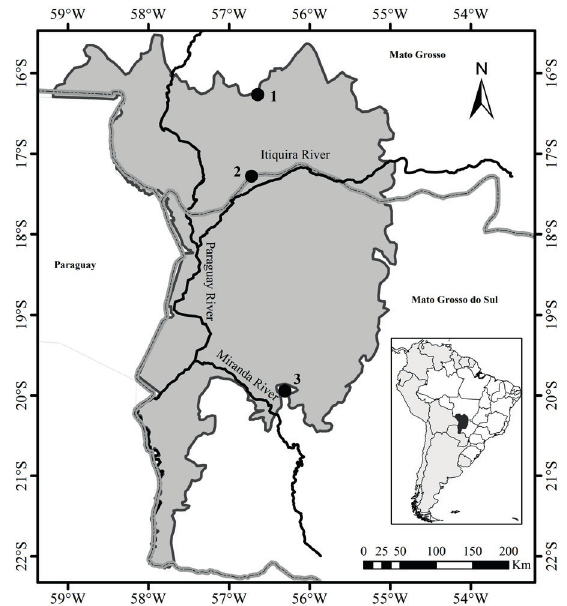
Figure 1 - Pantanal floodplain located in central-western Brazil, with the capture and gold mining sites, indicated by point location. Here, 1 - municipality of Poconé, Mato Grosso state (16 o 16’1.97”S, 56 o 37’35.51”W); 2 - Fazenda São Bento (17 o 20’35.79”S, 56°43’39.33”W); 3 – Refúgio Ecológico Caiman (19 o 57’15.58”S, 56 o 18’15.20”W), municipality of Miranda, Mato Grosso do Sul